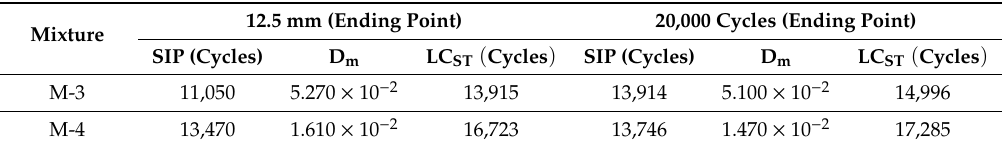
Table 2. The results of SIP, D m and LC ST